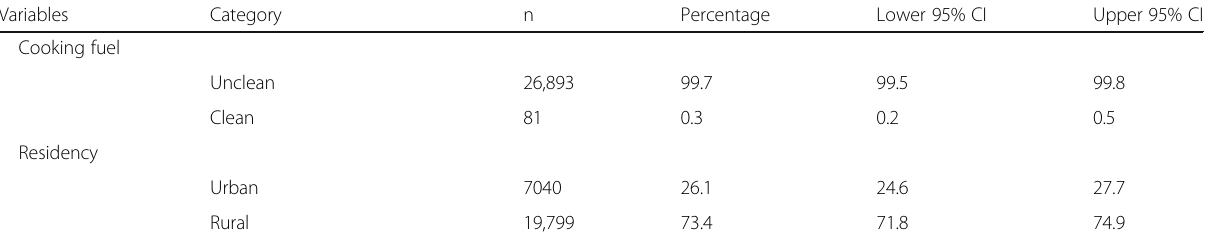
Table 2 Sample characteristics ( n = 26,974) (Continued)